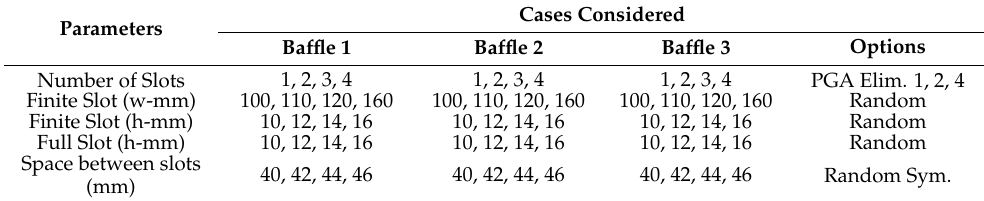
Table 2. Baffle geometry cases considered in the vertical baffle design.